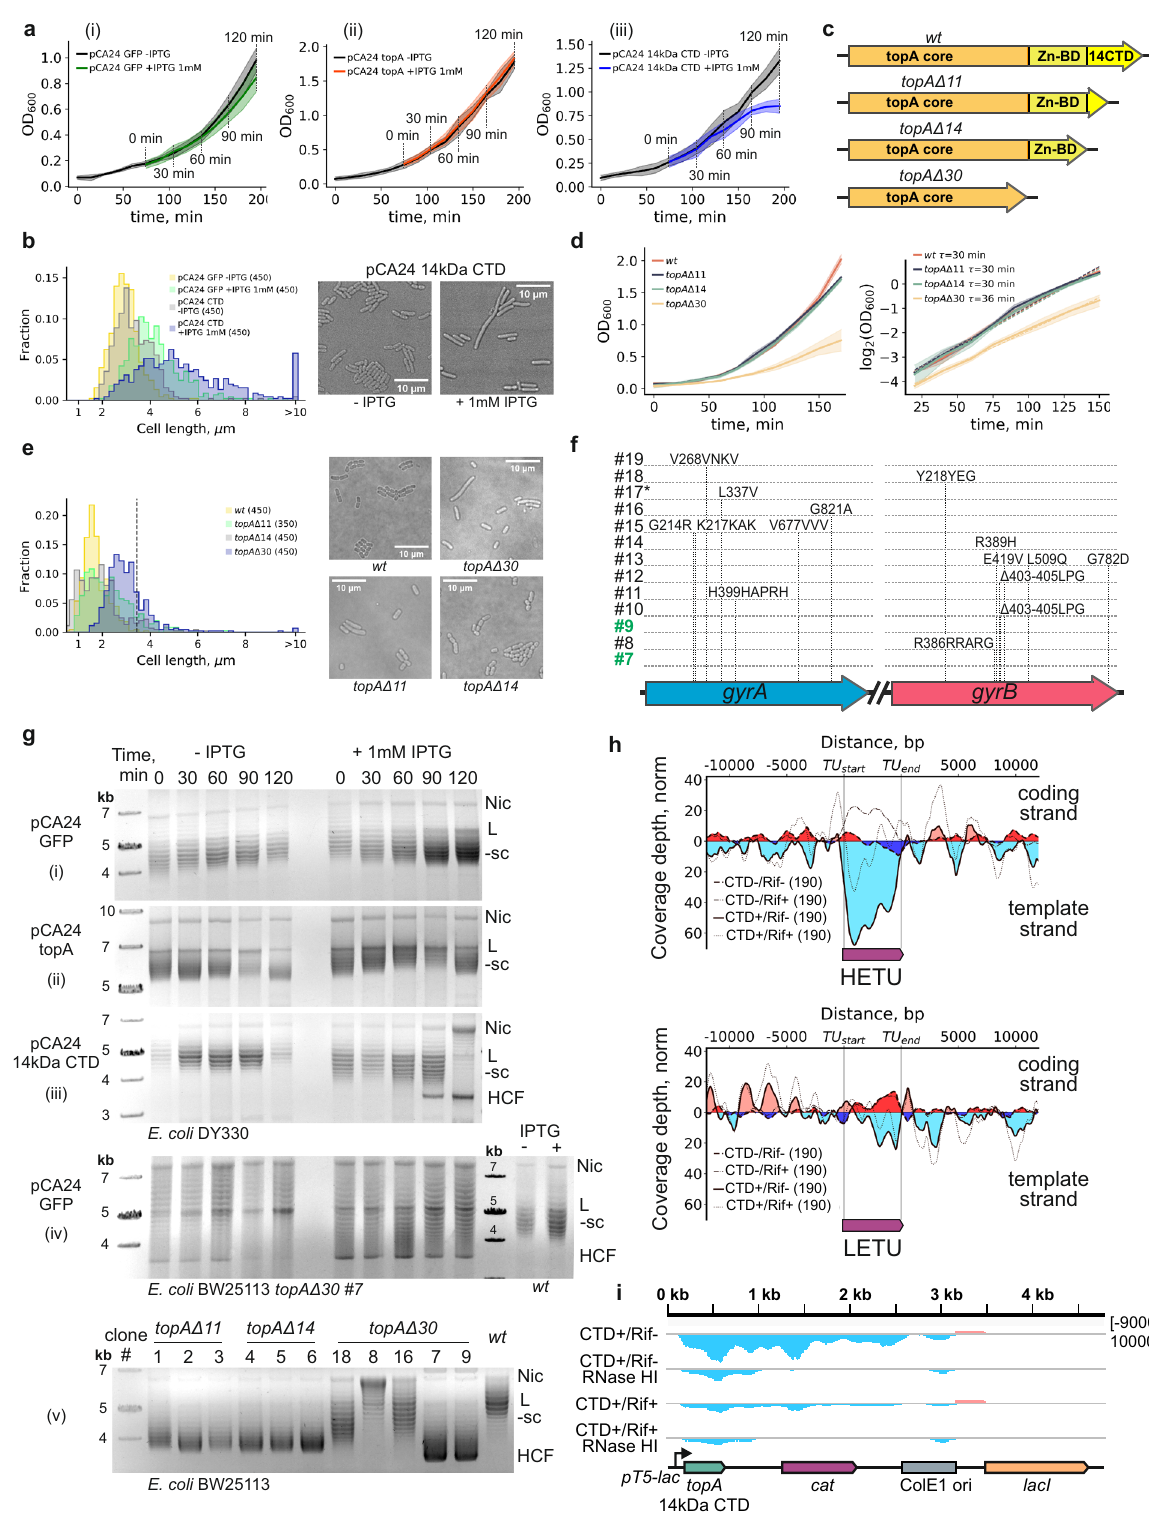
(Fig. 5giv), indicating that uncoupling of RNAP:EcTopoI complex or EcTopoI inactivation and active transcription together contribute to this phenomenon. These results are consistent with the R-loop accu- mulation